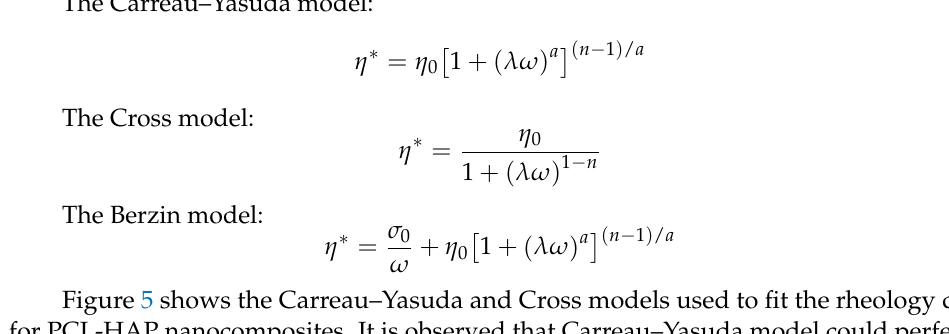
Figure 4. ( a ) Complex viscosity, ( b ) Storage modulus, ( c ) Loss modulus, and ( d ) Damping factor curves of PCL and PCL/HAP composites.